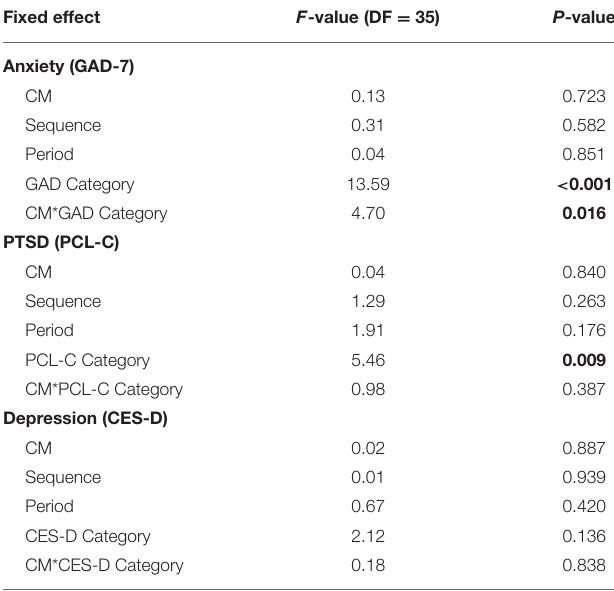
TABLE 3 | Linear mixed model fixed effects (Type-III